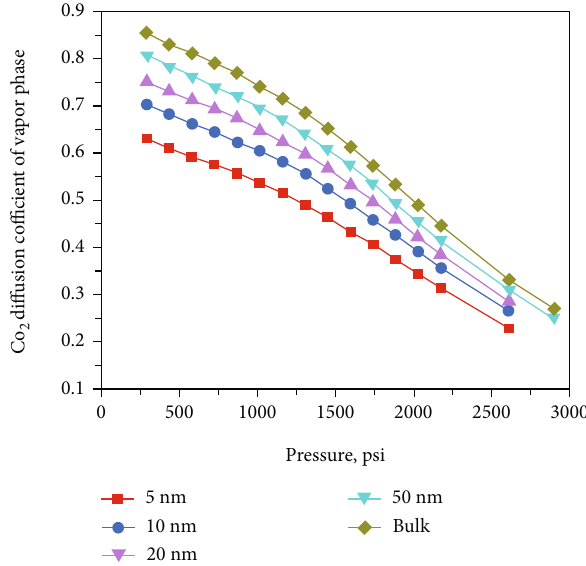
Figure 21: CO di ff usion coe ffi cient of vapor phase for Bakken 2 tight oil versus pressure at various pore radii at T = 230 °